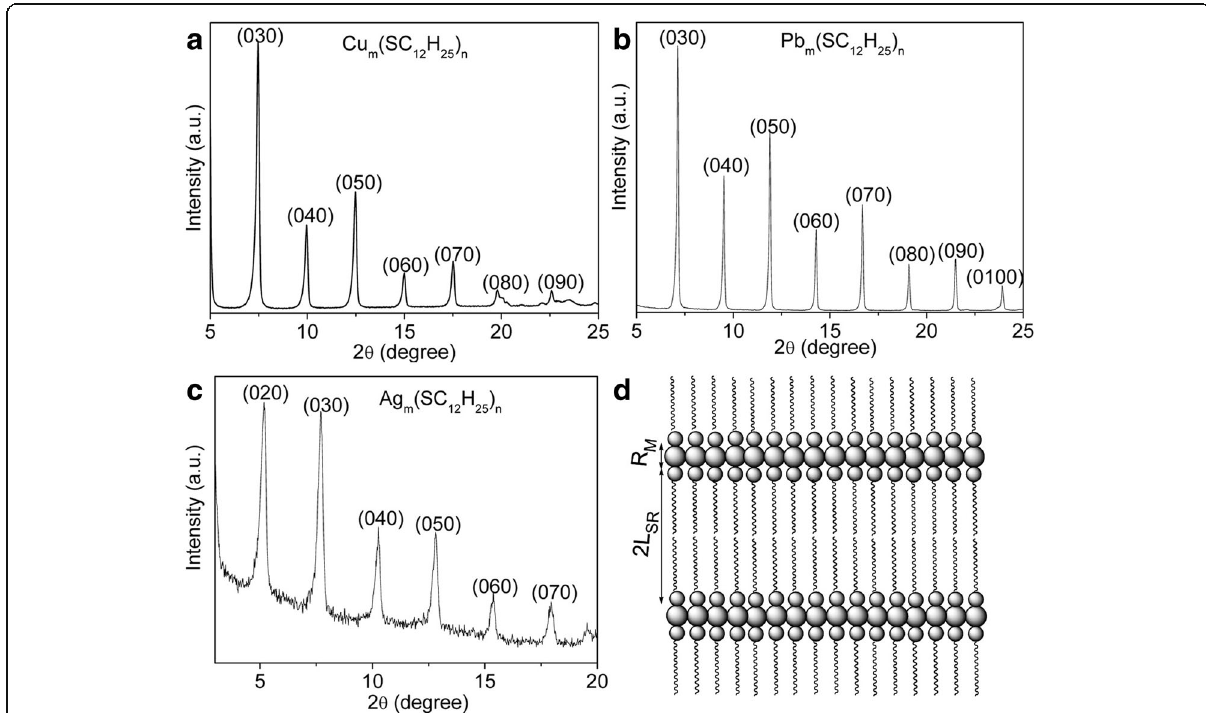
Fig. 3 Representative XRD patterns of the intermediate compounds obtained at the early stage. a Cu-thiolate compound. b Pb-thiolate compound. c Ag-thiolate compound. d Scheme of the layered structure formed at the initial reaction